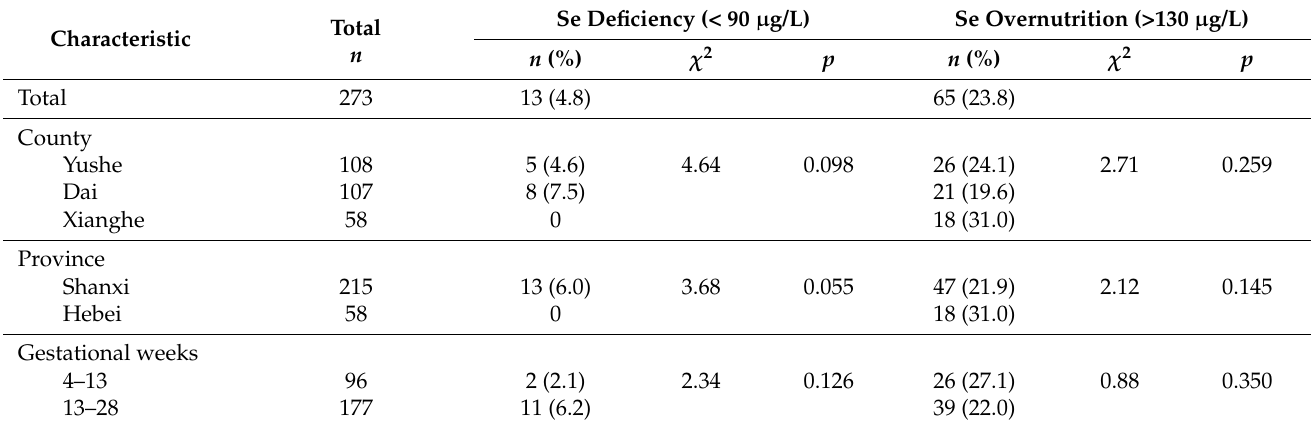
Table 1. Prevalence of Se deficiency and overnutrition among pregnant women in three counties of northern China. Characteristic